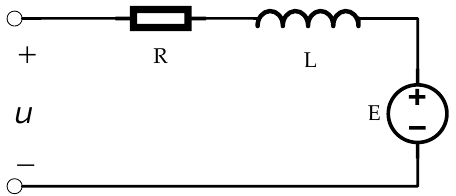
Figure 1. The electrical model.